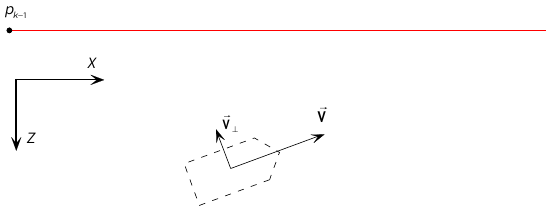
Figure 19. Introducing of lateral movement.